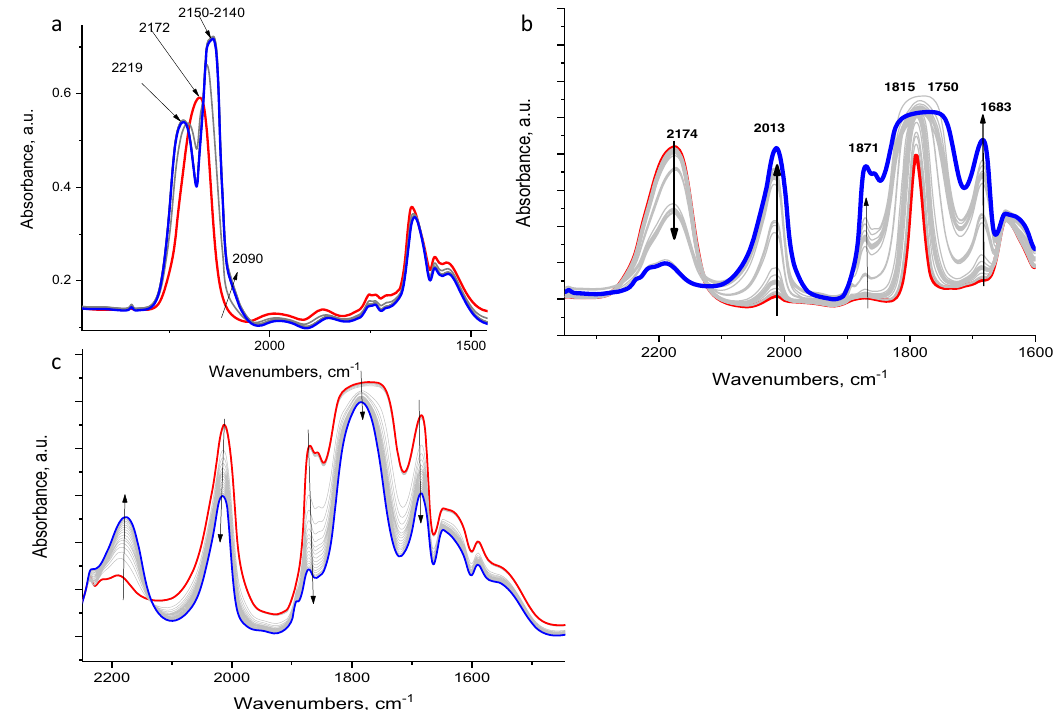
Fig. 2 Monitoring NO + interaction with adsorbates. a In-situ FTIR during sequential CO adsorption (2 Torr) at 100 K on H-SSZ-13 (Si/Al ~12) which was previously reacted with NO 2 at RT to form NO + and NO 3 − . Excess of NO 2 was removed by vacuuming at 10 − 6 Torr at RT. b In-situ FTIR during sequential NO adsorption (2 Torr) at 100 K on H-SSZ-13 (Si/Al ~12) that was previously reacted with NO 2 at RT Excess of NO 2 was removed by vacuuming at 10 − 6 Torr at RT. c In-situ FTIR during 10 − 7 Torr vacuum applied after B at 100 K. NO leaves Zeo-NO + -NO complex under vacuum, restoring NO + . The zeolite pellet itself was used as an IR background.